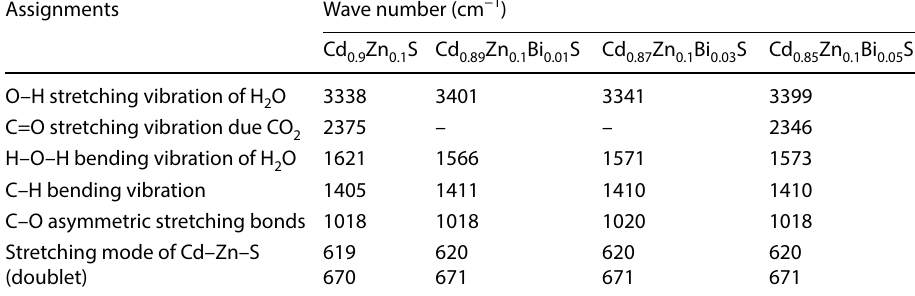
Assignments Zn Bi S 0.9-x 0.1 x